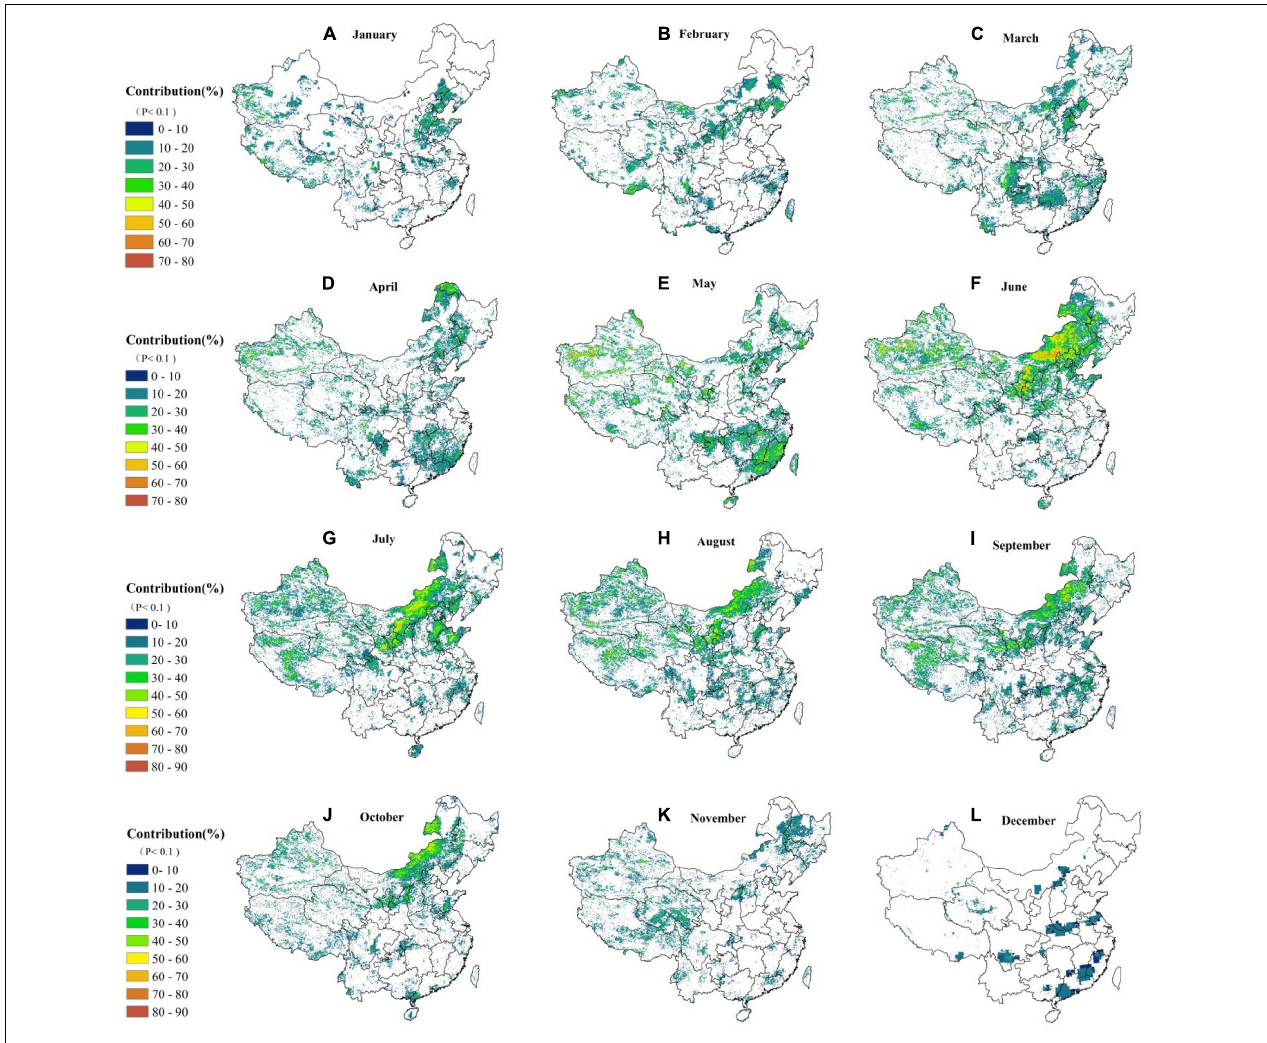
FIGURE 7 | The R 2 of monthly NPP and SPEI 3 in different months over a period of 1982–2012. From Images (A) to (L) stands from January to